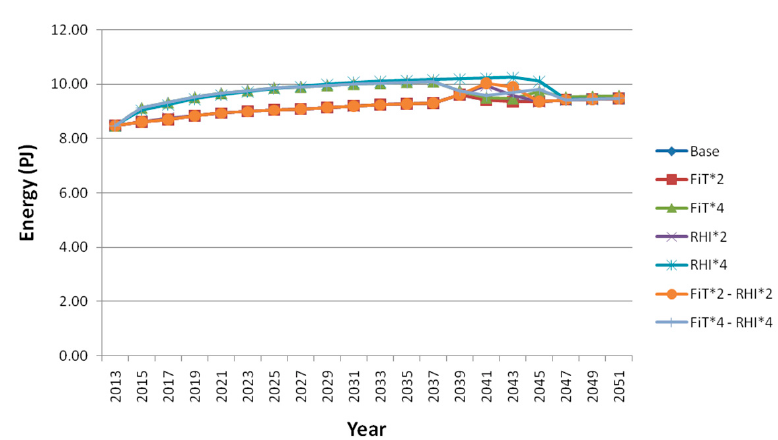
Figure 16. Specialist pig farms—grid electricity consumption. Energies 2016 , 9 , 1038